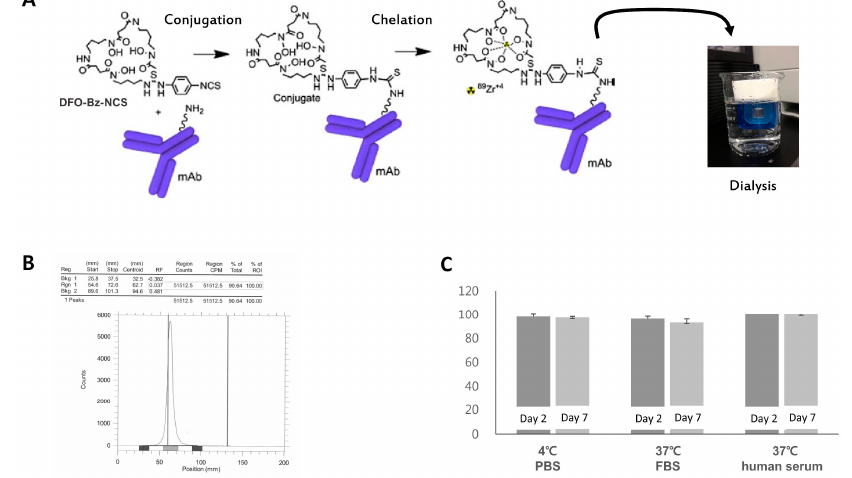
Figure 1. Schematic diagram for radiosynthesis of Zr-89 ATPS mAb ( A ). DF-Bz-NCS was first conjugated with ATPS mAb, and then Zr-89 was chelated to the conjugate. Labeling e ffi ciency ( B ) and in-vitro stability ( C ) of Zr-89 ATPS mAb measured by radio-TLC. ATPS, Adenosine Triphosphate Synthase; mAb, Monoclonal antibody; Df-Bz-NCS, p-isothiocyanatobenzyl-desferrioxamine. Error bar = standard